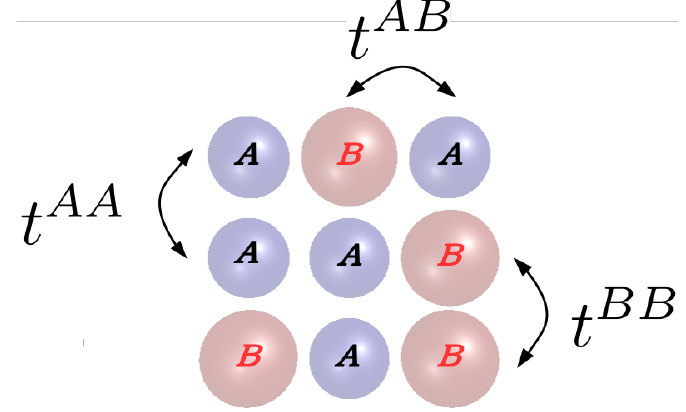
Figure 24. For off-diagonal disorder the hopping amplitude depends on the occupancy of the neighboring